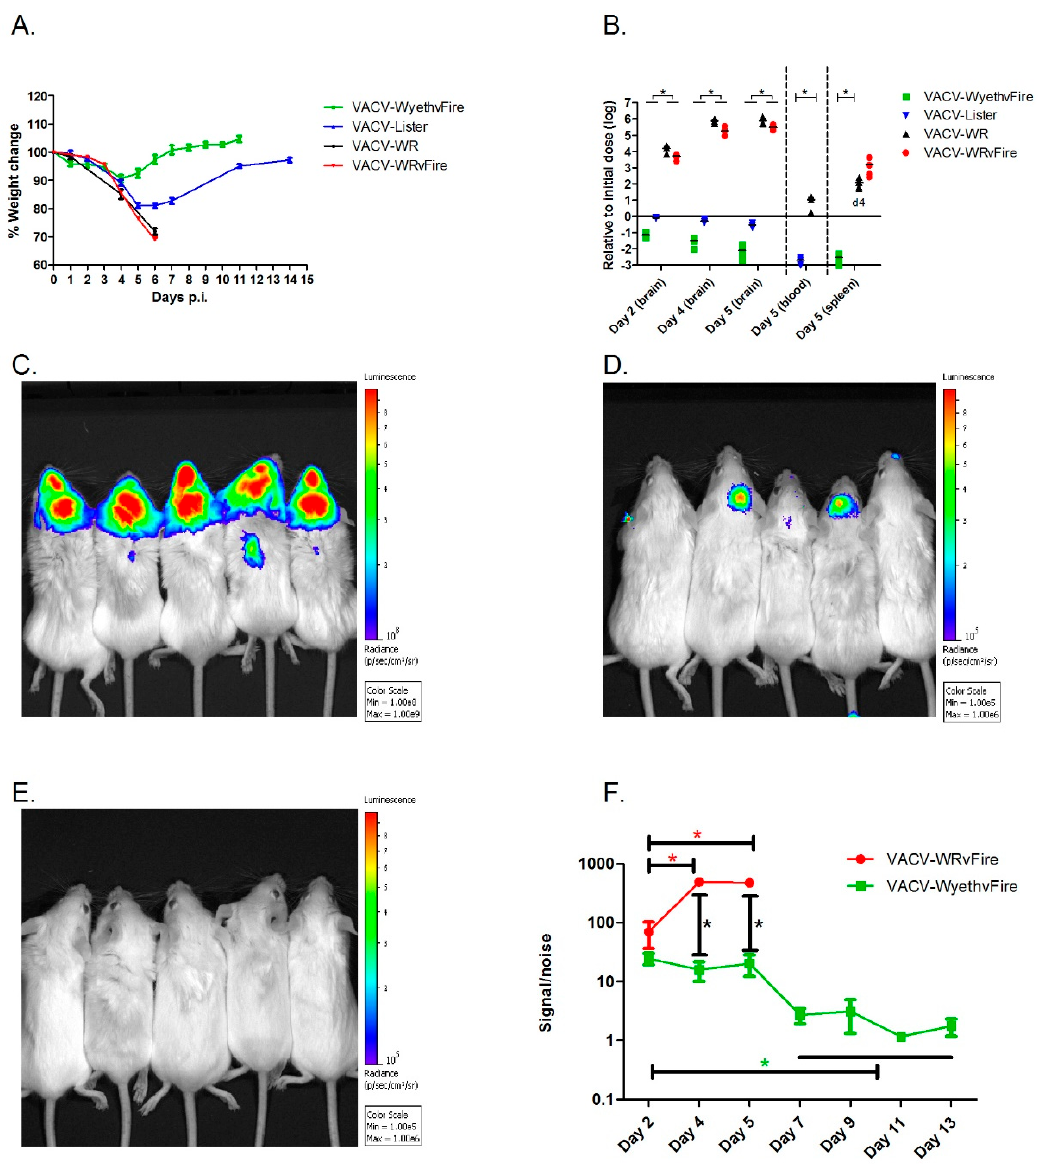
Figure 1. Disease progression following intracranial infection. Mice were injected intracranially with vaccinia virus-western Reserve (VACV-WR) (10 2 pfu), VACV-WR with the vFire cassette (VACV-WRvFire) (10 2 pfu), VACV-Lister (10 6 pfu) or VACV-WyethvFire (10 6 pfu). ( A ) Weight change following infection. ( B ) Viral loads, relative (log scale) to the initial infection dose, in brain (2, 4, 5 d.p.i.), blood (5 d.p.i.) and spleen (4 d.p.i. for VACV-WR, 5 d.p.i. for VACV-WRvFire and VACV-WyethvFire). All tissues were weight normalized for analysis. Asterisks denote p < 0.05 ( t -test). ( C ) In-vivo whole body imaging following VACV-WRvFire at 5 d.p.i. (photon flux color scale: 10 8 –10 9 p/s/cm 2 /sr). ( D ) In-vivo whole body imaging following VACV-WyethvFire at 5 d.p.i. (photon flux color scale: 10 5 –10 6 p/s/cm 2 /sr). ( E ) In-vivo whole body imaging following VACV-WyethvFire at 7 d.p.i. (photon flux color scale: 10 5 –10 6 p/s/cm 2 /sr). ( F ) Head signal intensity over the background noise at 2–5 d.p.i in VACV-WRvFire and 2–13 d.p.i in VACV-WyethvFire. Asterisks denote p < 0.05 in post-hoc t -test following 2-way ANOVA. Error bars represent standard errors.